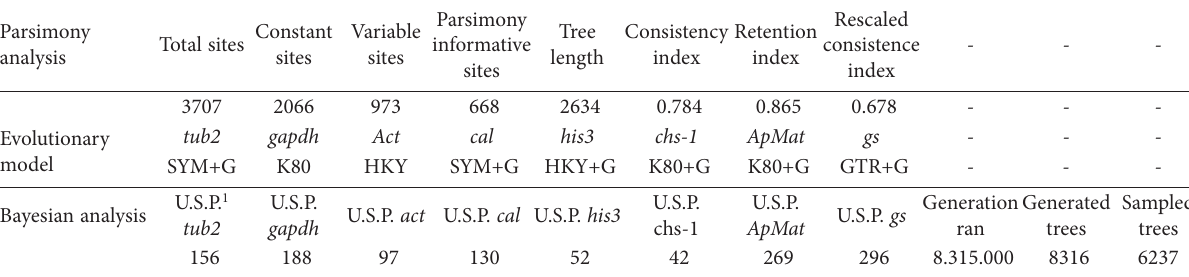
Table 3. Maximum Parsimony, evolutionary models and Bayesian analysis characteristics of this study. Parsimony